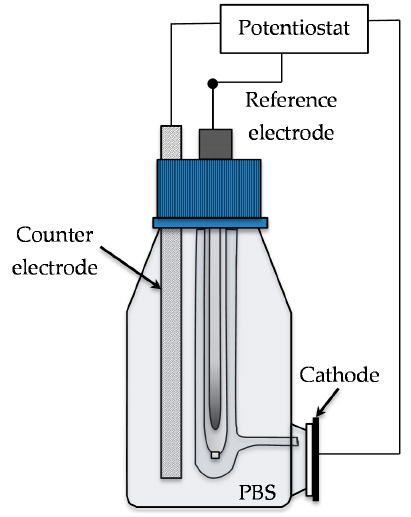
Figure 7. Sketch of the three electrode electrochemical setup for LSV (linear sweep voltammetry) measurement.